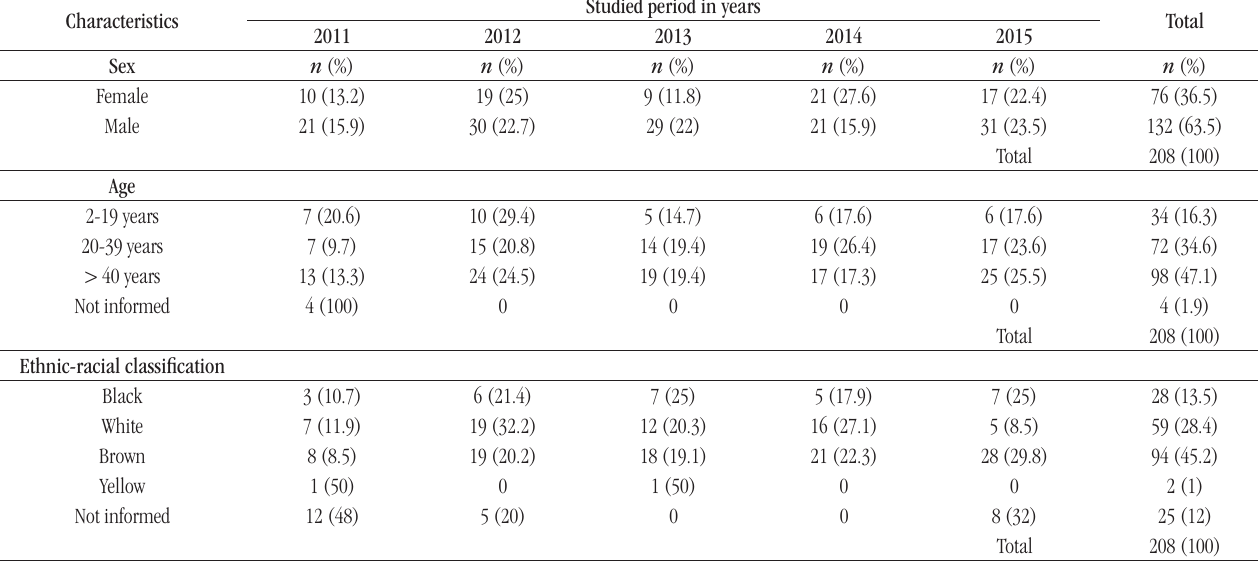
taBLE − Sociodemographic profile of deceased donors of solid organs ( n = 208) in the state of Espírito Santo, Brazil, from 2011 to 2015